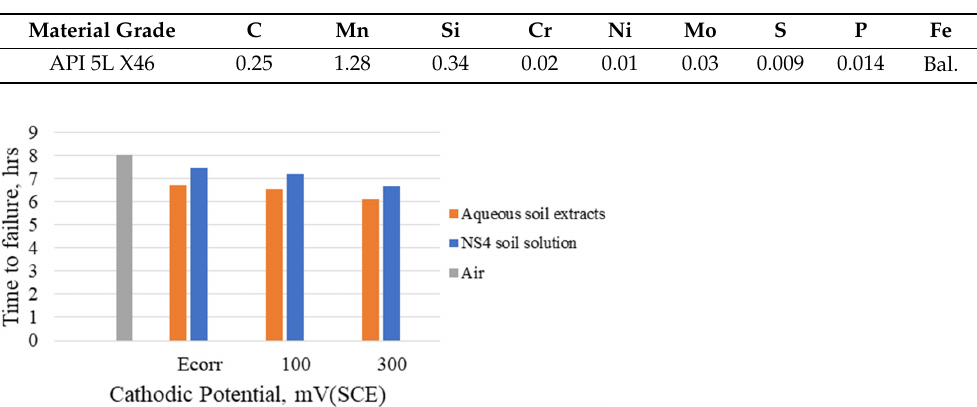
Figure 4. Variations in time to failure of the API 5L X46 exposed samples in air, aqueous soil extracts and NS4 solution at open circuit potential (Ecorr), 100 mV (SCE) and 300 mV (SCE) below corrosion potential. Data from [15].